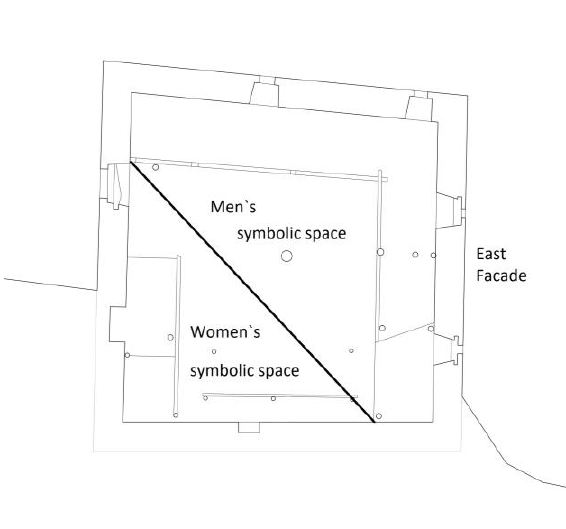
Figure 5. Inside of a Machubi, Zhibiani, Ushguli, CI-ESG, 2018 Figure 6. Symbolic use of Machubi 10, Chazhashi, Ushguli, based on Chartolani, 1961, p. 13.